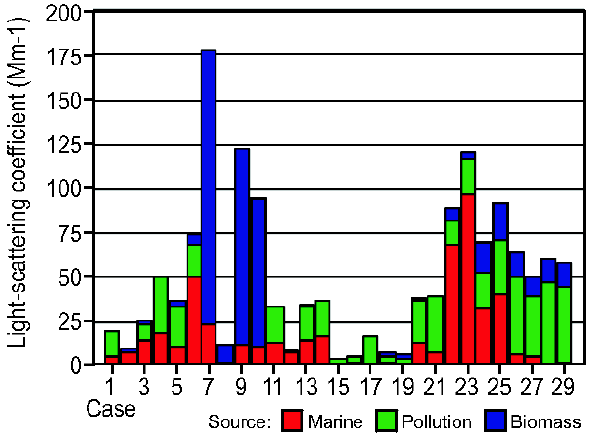
Fig. 9. Source contributions to the aerosol light-scattering coef- ficient ( σ sp ) for each of the three sources to each of the samples taken during the CARMA III study. The samples shown were taken consecutively between 6 and 26 August 2005.